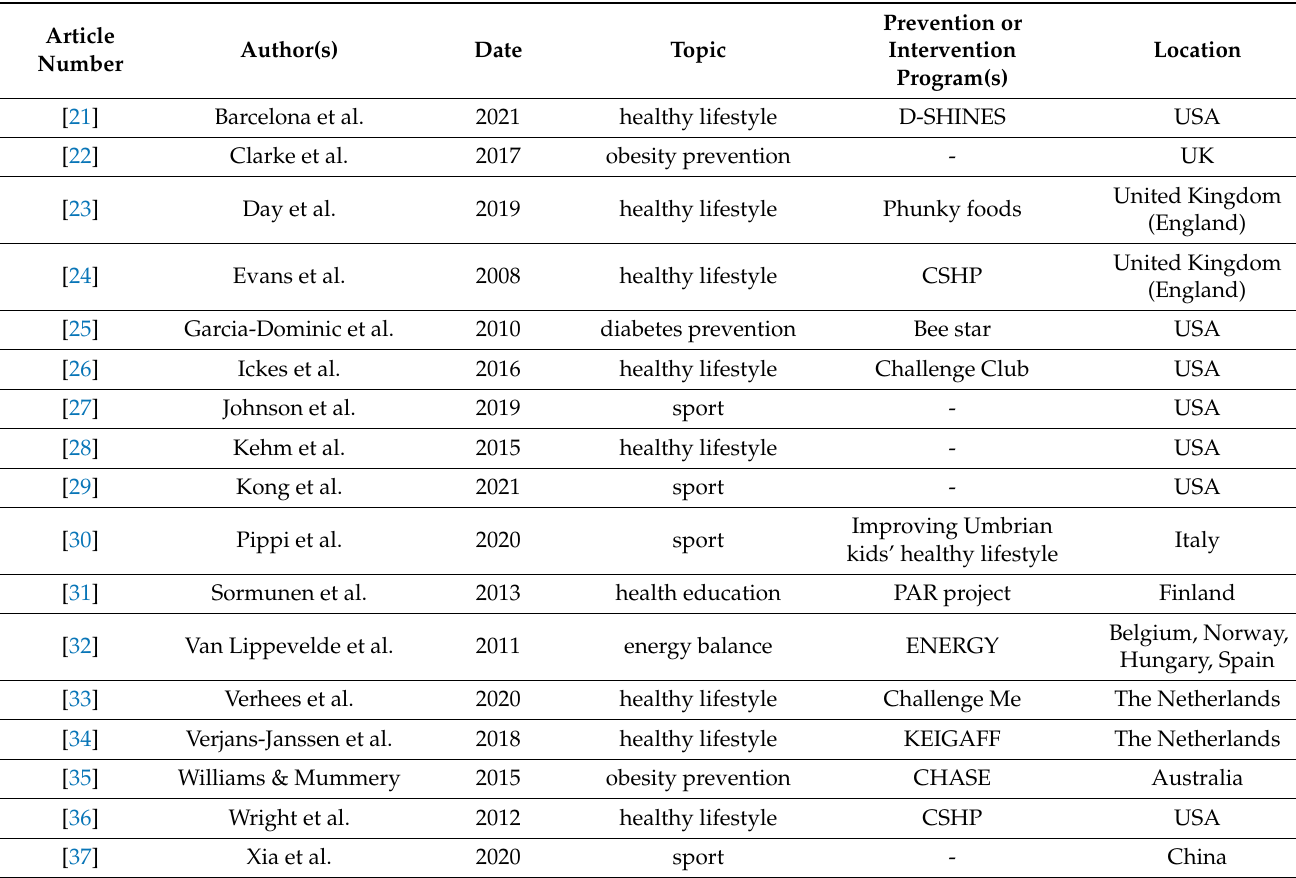
Table 1. Papers included in the systematic